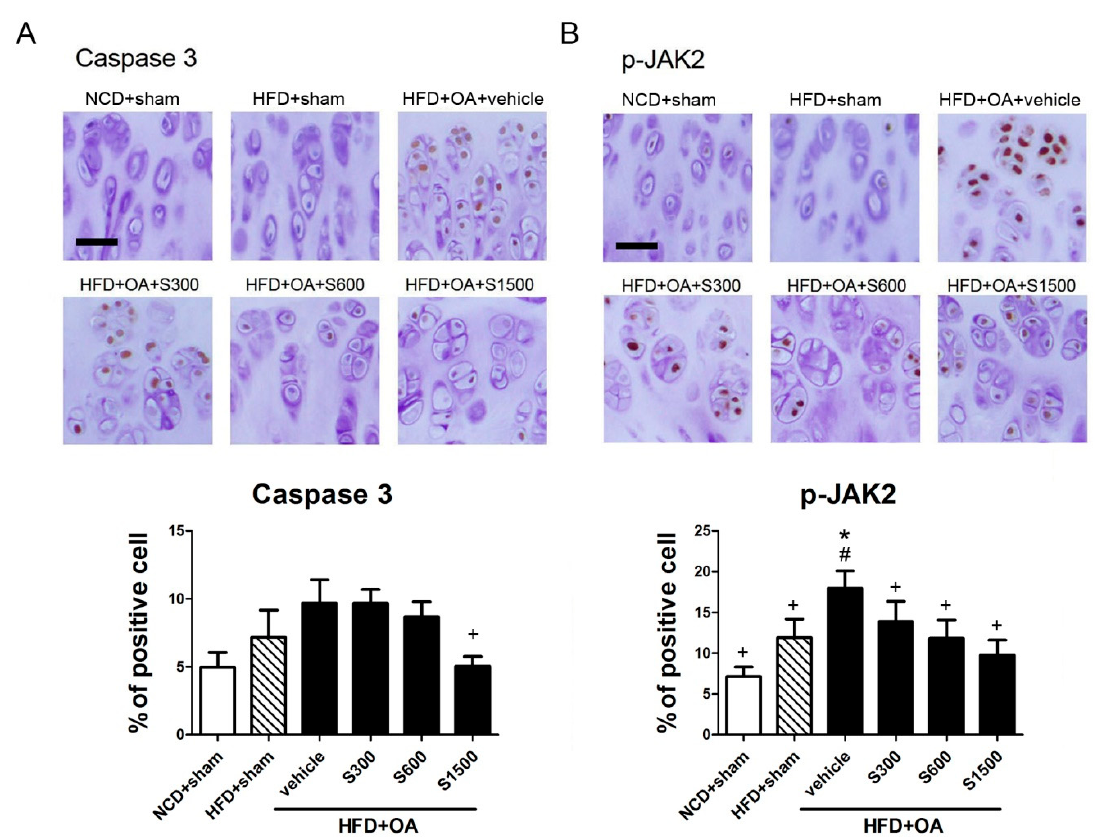
Figure 7. E ff ects of Shiikuwasha Extract (SE) on the expression of caspase 3 and p-JAK2 in osteoarthritis (OA) joints. Rats underwent ACLT / MMx in the right knee. SE was administered orally daily for 9 weeks after the operation. Immunohistochemical staining was used to identify the expression of ( A ) caspase 3, ( B ) p-JAK2 in the articular cartilage. ( × 200 magnification). Scale bars = 50 µ m. The data are expressed as means ± SEM ( n = 6). * p < 0.05 when compared to the NCD + sham group; # p < 0.05 when compared to the HFD + sham group; + p < 0.05 when compared to the vehicle group. The letters ( p < 0.05) were calculated by one-way ANOVA and Duncan’s multiple range test.